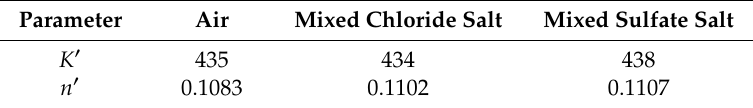
Figure 3. Cyclic stress–strain relationships of samples under di ff erent deformation environments. Table 4. Low-cycle fatigue characteristics parameters K (cid:48) and n (cid:48)